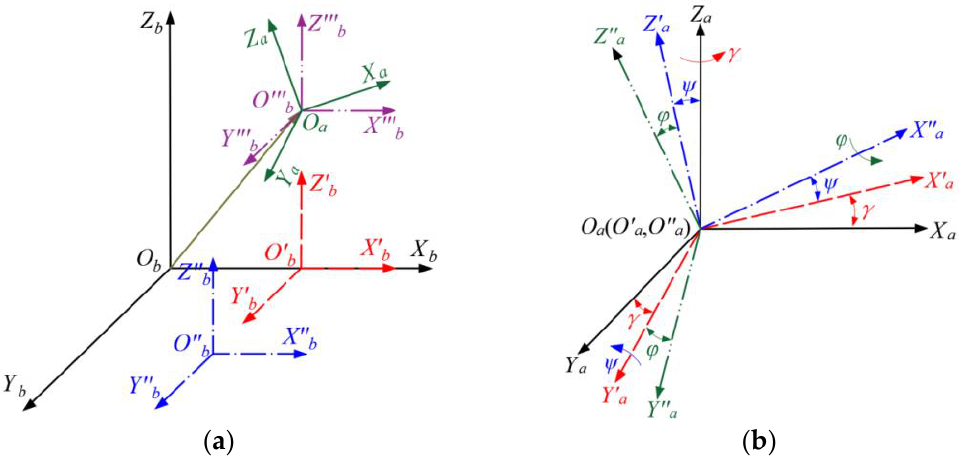
Figure 4. Coordinate transformation diagram of the 6-UPS parallel mechanism: ( a ) Schematic diagram of translation; ( b ) Schematic diagram of rotation.